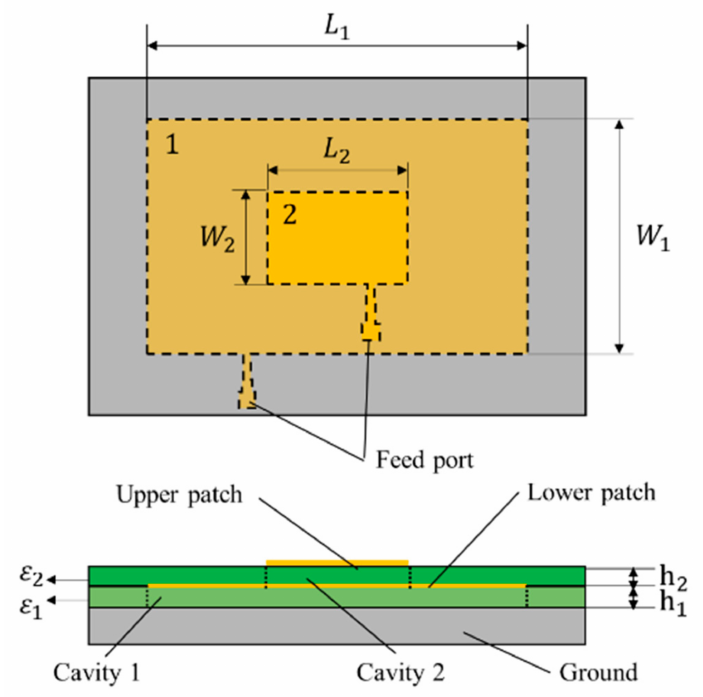
Figure 5. Schematic diagram of multilayer patch antenna